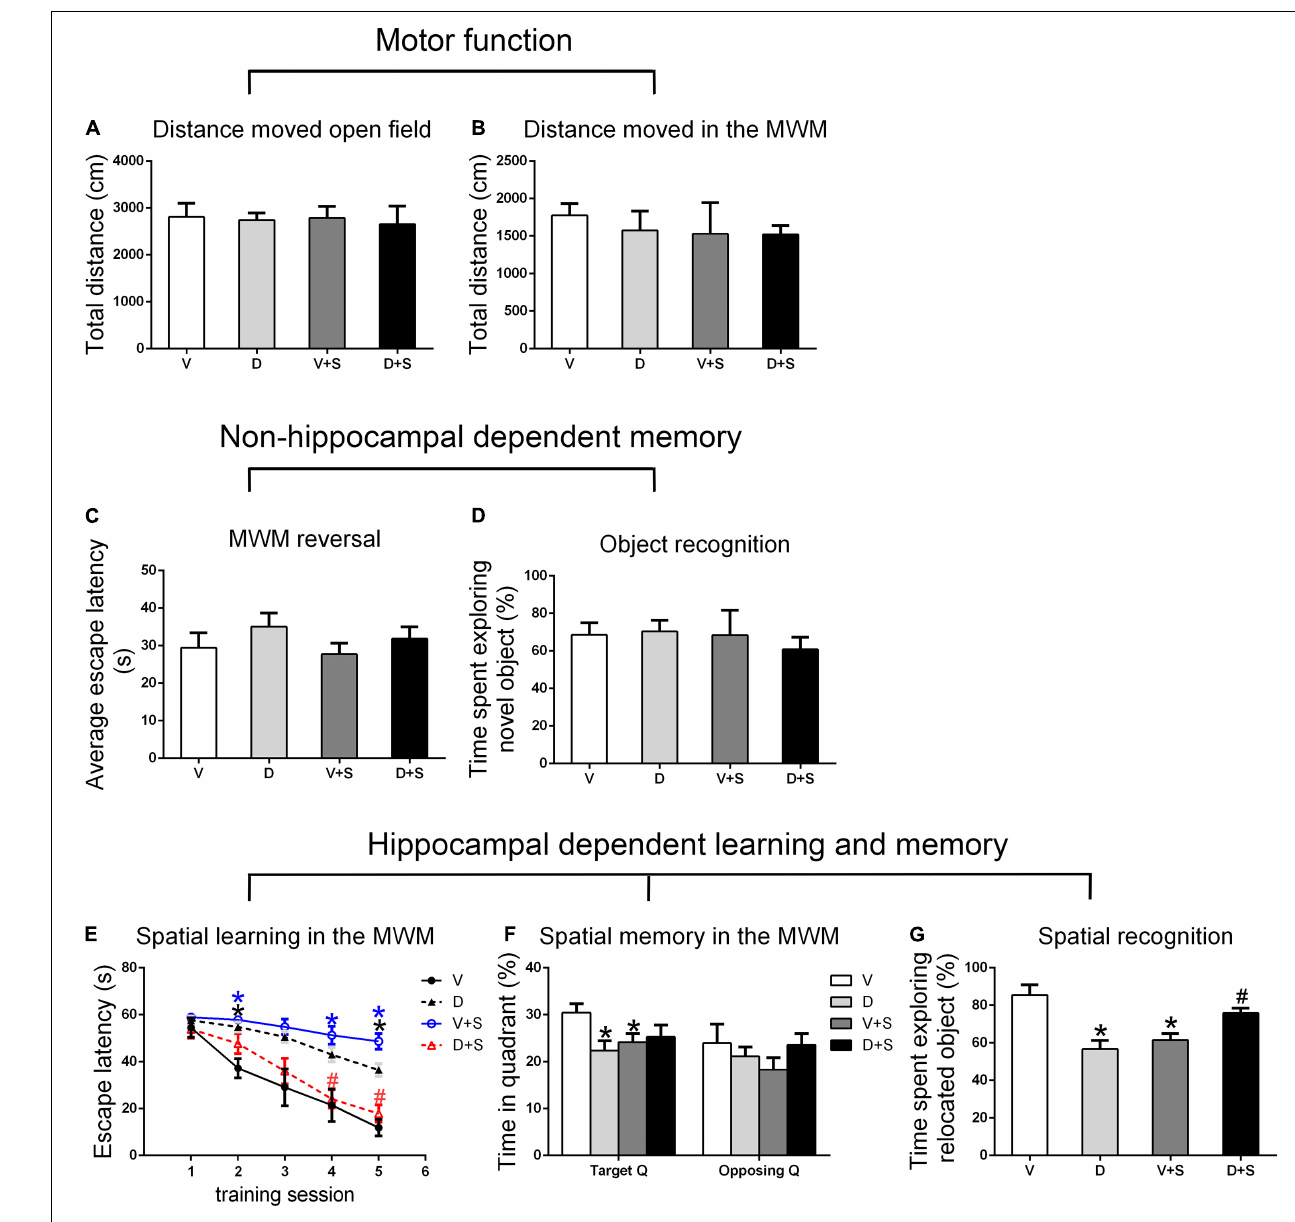
FIGURE 4 | Open field behavior, learning, and memory performance in the four groups at 2 weeks postoperatively. (A) Distance moved in the open field test (cm). (B) Distance moved (cm) in the MWM during the first test as a measure of motor function. (C) Cognitive flexibility in the MWM. Average escape latency (s) during the four MWM reversal trials. (D) Object recognition in the NO test. (E) Spatial learning in the MWM. Average escape latency (s) is shown for the five training sessions in the maze. (F) Spatial memory in the MWM. The percentages of time in the target quadrant (Target Q) and time in a quadrant opposite to the target quadrant (Opposing Q) are shown. (G) Spatial recognition in the NL test. Exploration time of the relocated object as a percentage of total object exploration is shown. The data are presented as the means ± SEM for each group ( n = 10 per cohort). * p < 0.05 compared to Group V, # p < 0.05 compared to Group V +